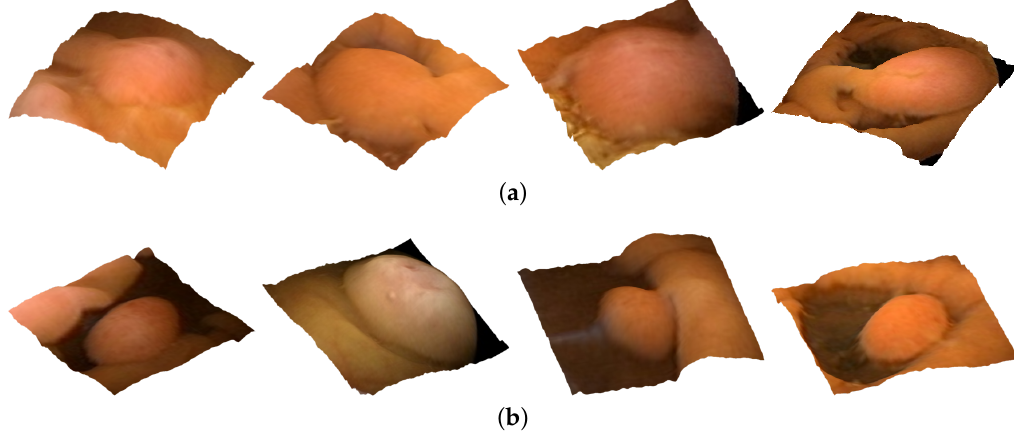
Figure 2. Shapes or geometry of polyps significantly differ along the GI tract. Examples of polyps: ( a ) pedunculated/stalked or subpedunculated; ( b ) sessile. We show a 3D representation of VCE frames obtained using shapes from shading techniques